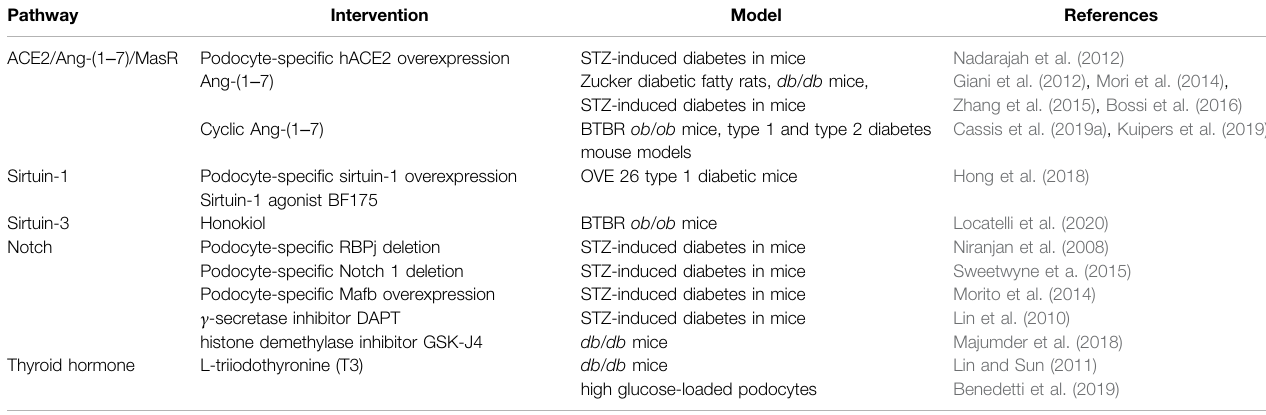
TABLE 1 | Selected targetable signaling pathways in experimental diabetic nephropathy mentioned in this review. Pathway Intervention